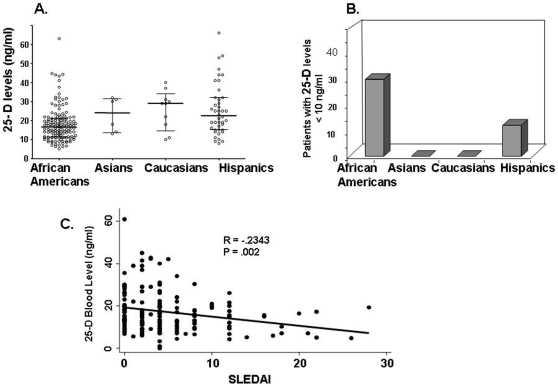
Assessment of 25-D levels in patients with SLE.The distribution and median blood level for 25-D (+/− 1 SD) is shown for each ethnic group (A). Severe vitamin D deficiency (defined as a blood level of 25-D less than 10 ng/ml) is most prevalent among African American and Hispanic patients (B). Disease activity scores (SLEDAI) exhibited an inverse correlation with 25-D levels (C).